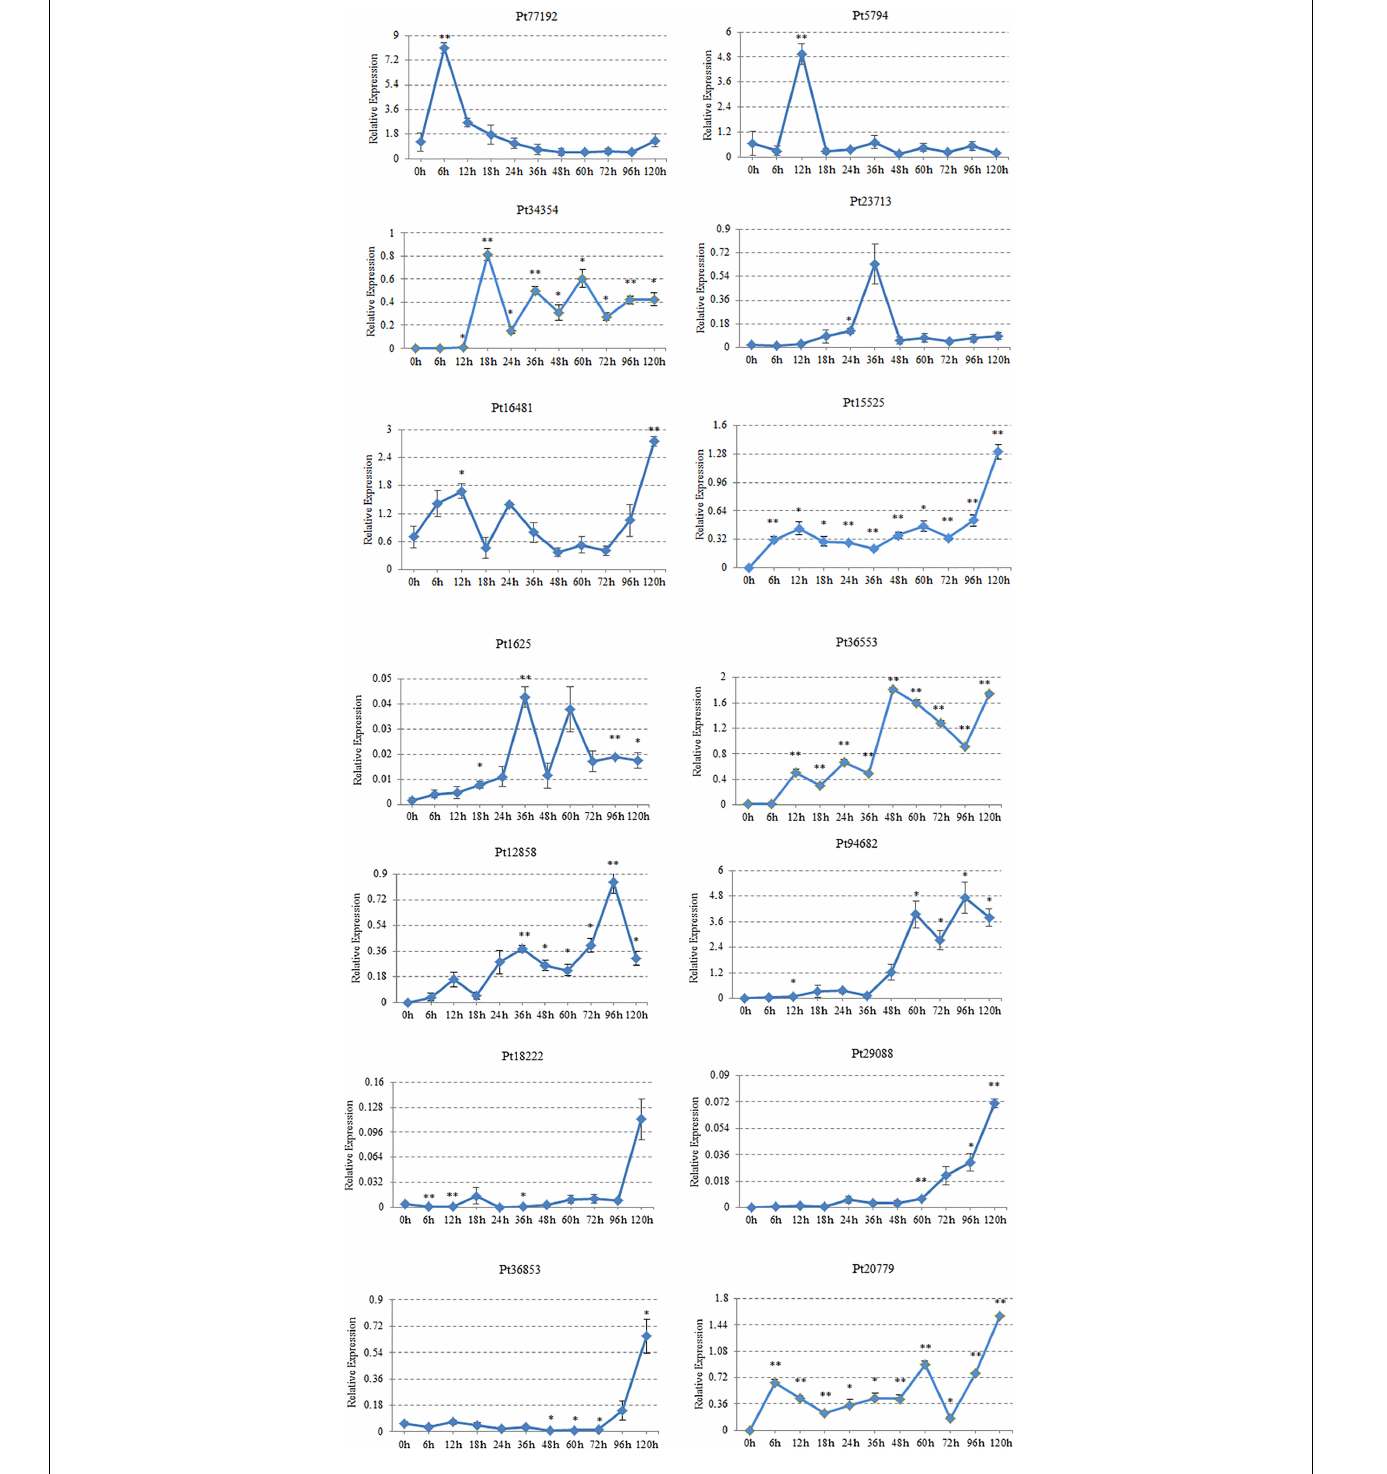
FIGURE 6 | Gene expression profiles for 14 candidate effector proteins. Plant samples were taken at these inoculation time points (X-axis). h, hours post-inoculation (hpi). Gene expression level, relative expression (Y-axis). The expression levels of each gene were calculated according to the 2 − (cid:49)(cid:49) CT method compared with an endogenous gene EF1. Three technical replicates and biological repetition for each treatment were analyzed. Calculations of the mean and standard error were performed using Microsoft Excel software. Asterisks indicate significant differences ( ∗∗ P < 0.01, ∗ P < 0.05) relative to the US sample determined using Student’s t